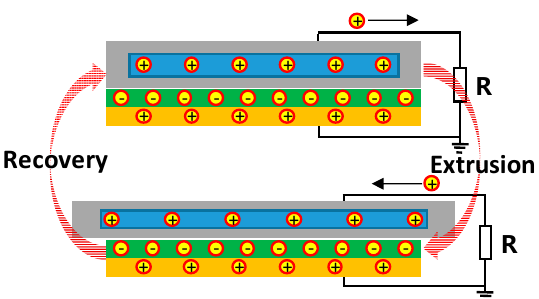
Figure 2. Energy conversion schematic of flexible and stretchable energy harvester based on gallium liquid-metal alloy.